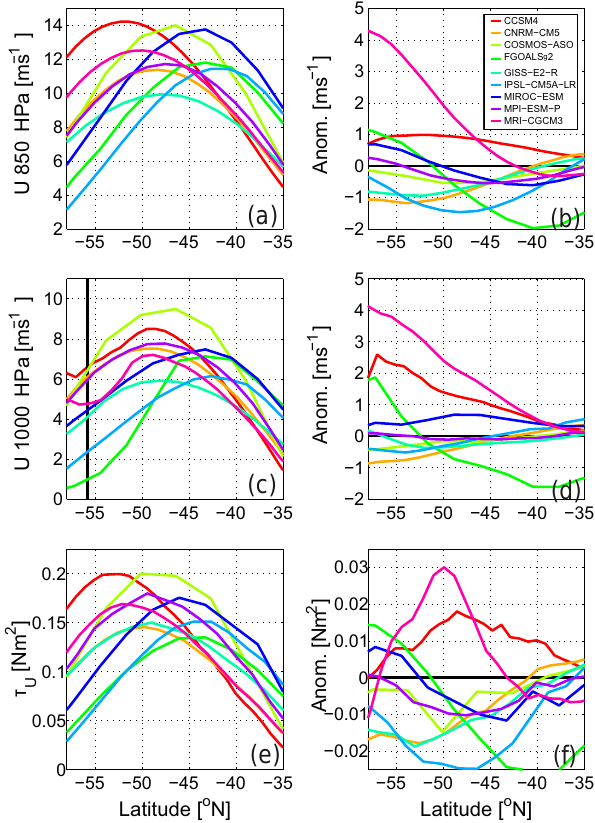
Figure 1. Zonal mean Southern Ocean winds. (a) PI wind speed U at 850hPa, (b) LGM − PI anomaly, (c) PI wind speed U at 1000hPa, and the ERA-Interim Bracegirdle et al. (2013) latitudi- nal position of the surface jet maximum to represent the observa- tional position (d) and the 1000hPa LGM − PI anomaly, (e) PI surface shear stress τ U , and (f) the τ U LGM − PI anomaly. Colours as shown in the legend in panel (b) denote the individual models. All values are annual